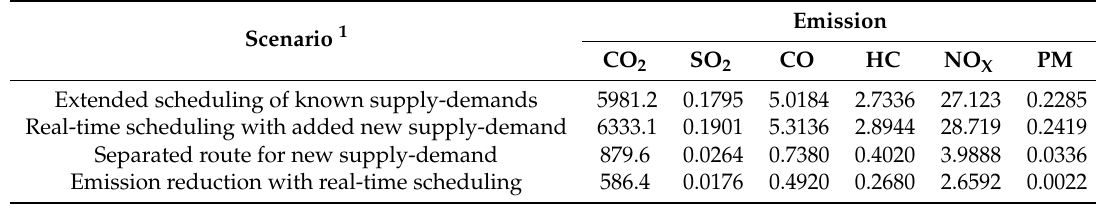
Table 12. Calculated GHG emission in the case of oil-based electricity